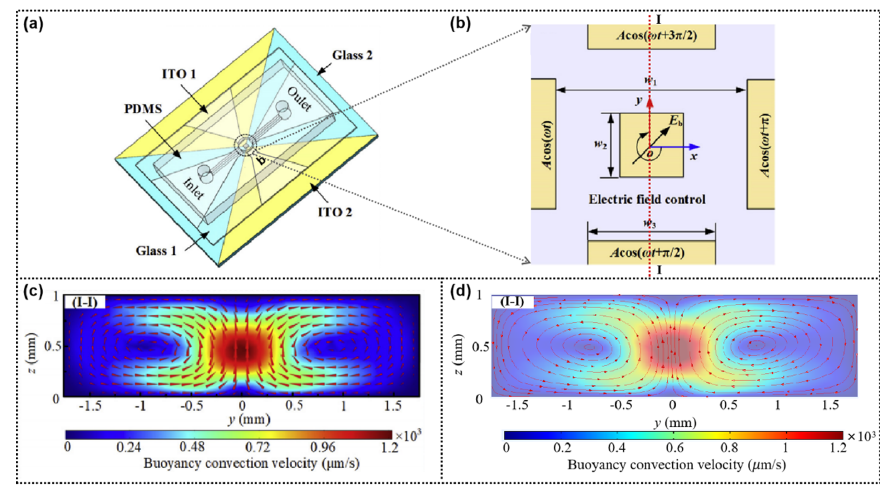
Figure A3. Model evaluation (validation of the buoyancy flow): ( a ) Schematic diagram of the separator from Zhang et al.; ( b ) electrodes arrangements (the simulated cross section is highlighted by the red dashed line I-I); Buoyancy flow at U DC = 7 V: ( c ) calculations from Zhang et al. and ( d ) calculations using the proposed model from this work.